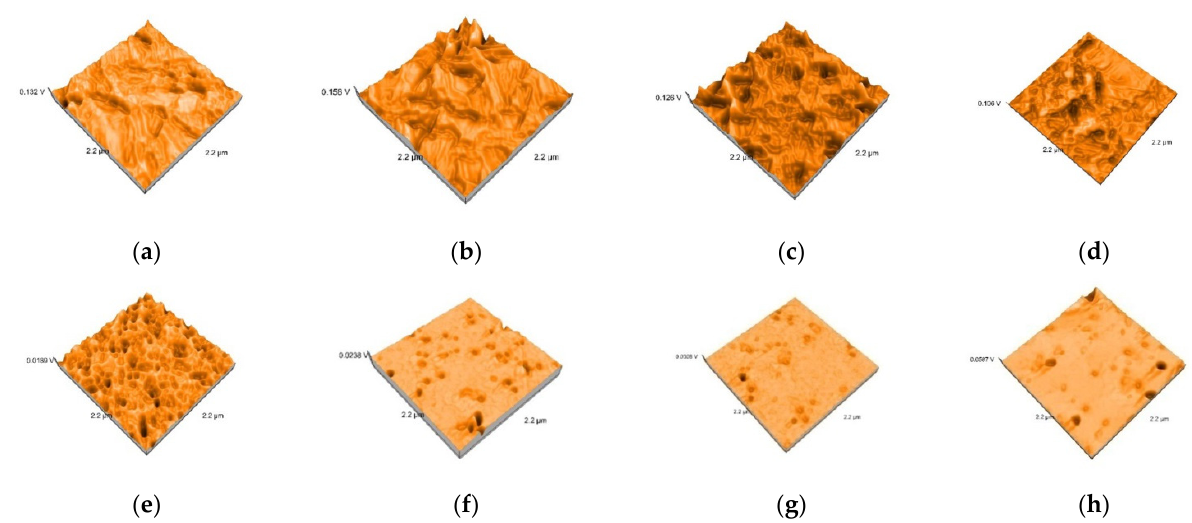
Figure 7. 3D images of Hyramic specimens: ( a ) Hyramic tribochemical silica airborne particle abrasion, ( b ) Hyramic sandblasted, ( c ) Hyramic etched, ( d ) Hyramic polished, ( e ) Hyramic tribochemical silica airborne particle abrasion and glazed, ( f ) Hyramic sandblasted and glazed, ( g ) Hyramic etched and glazed, ( h ) Hyramic polished and glazed.